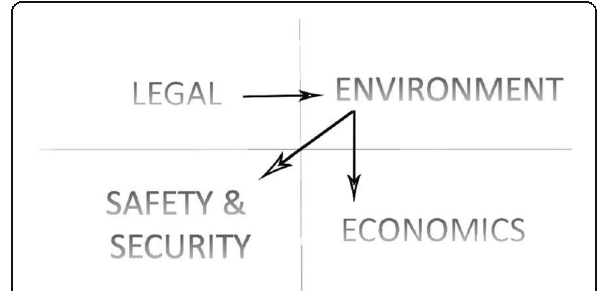
Fig. 1 Diversification of articles and dissertations related to